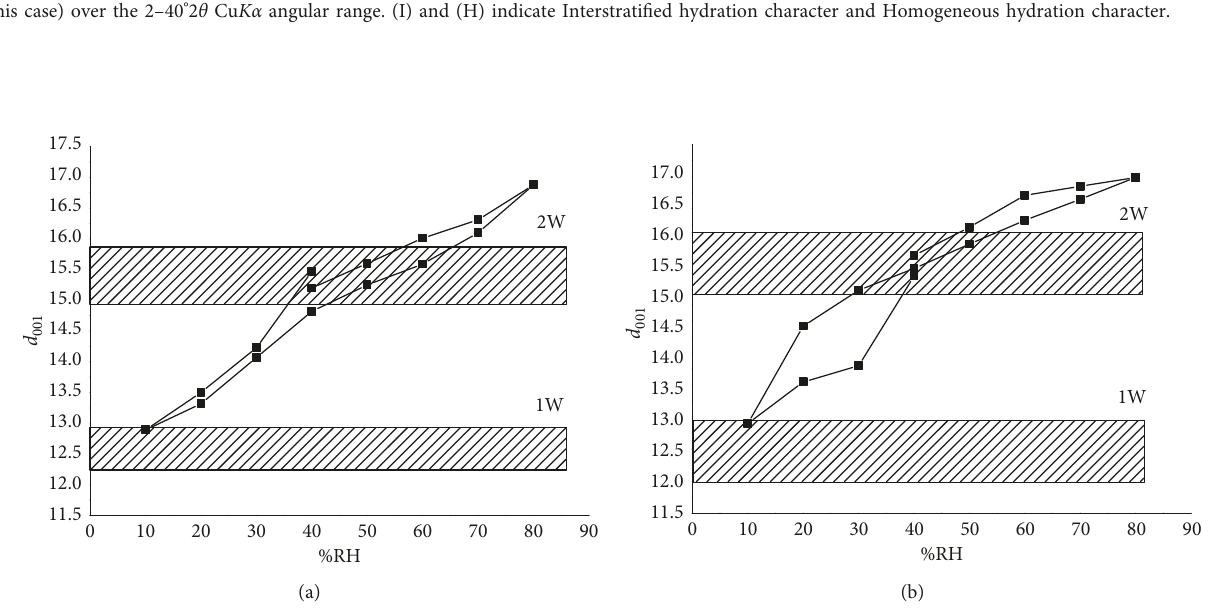
Figure 3: Evolution of the given d 001 spacing values according to % RH values during the first and the second